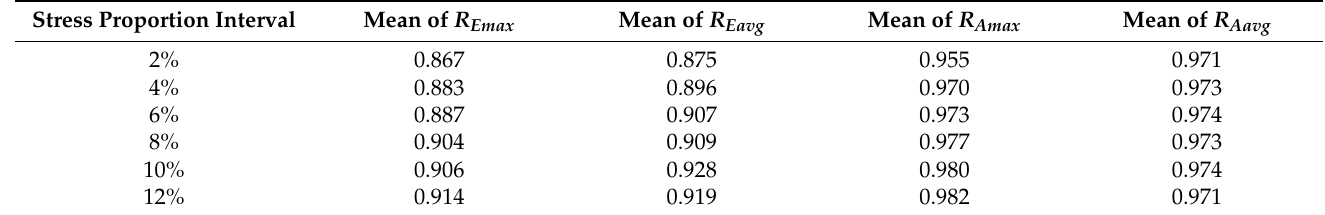
Figure 9. b value and its fitting goodness at different stress intervals for specimen G-10-10. The range of b Amax values is between 1.01 to 1.99.